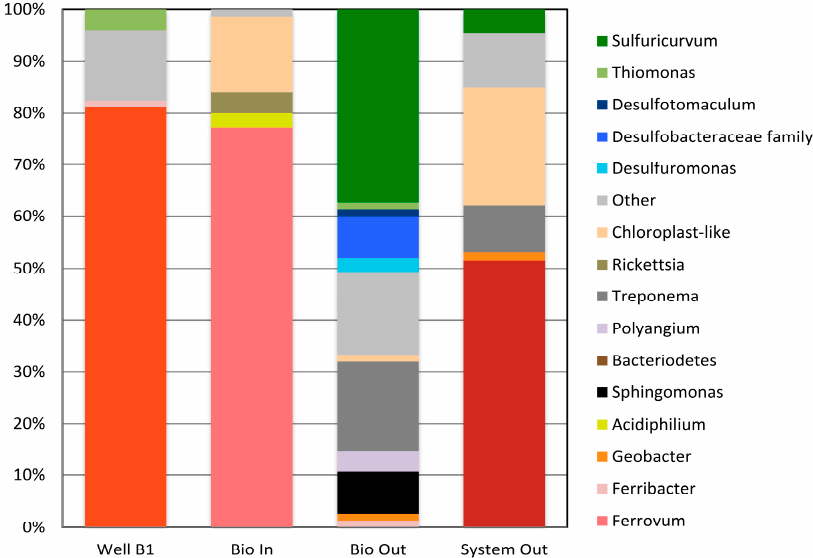
Figure 3. Abundance of bacterial 16S rRNA gene sequences in water samples collected at four sampled sites at the Tab-Simco site (data from Burns et al. [17]).